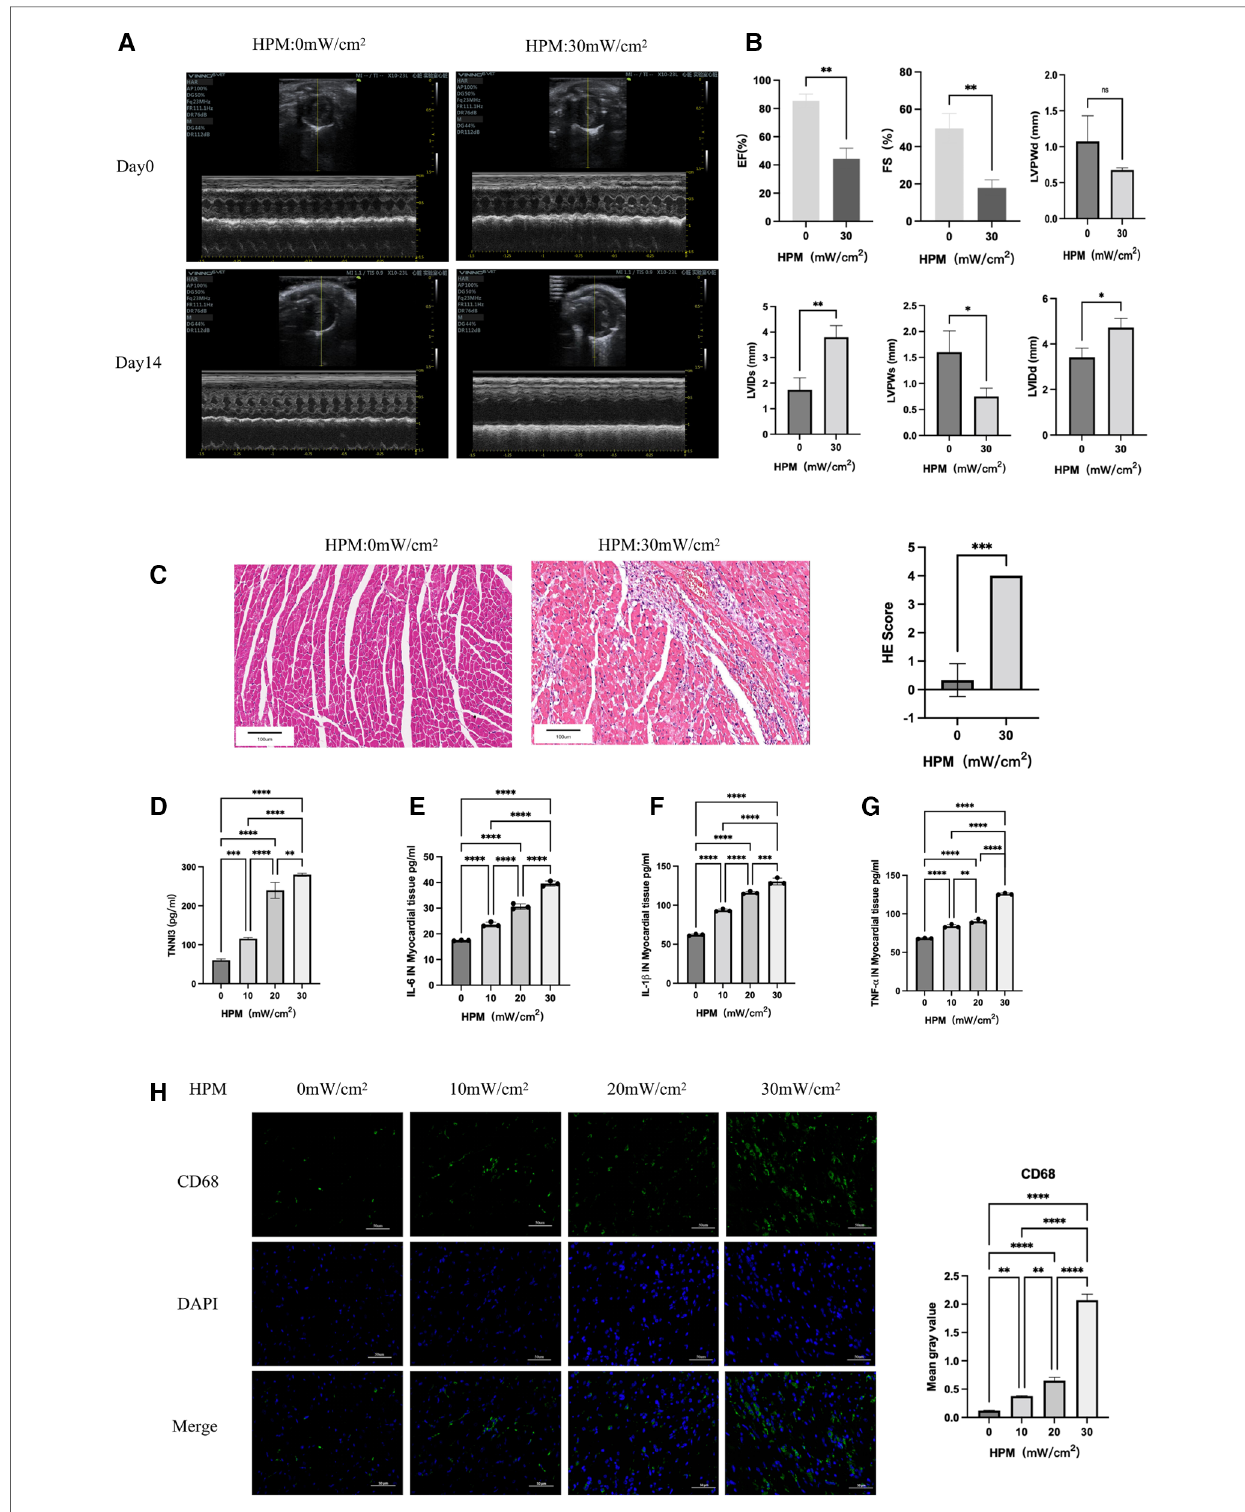
FIGURE 1 HPM causes myocardial damage in mice ( n =6). ( A ) Echocardiography in HPM 0 mW/cm 2 and HPM 30 mW/cm 2 mice pre and after HPM. ( B ) Parameters of HPM 0 mW/cm 2 and HPM 30 mW/cm 2 mice cardiac function, EF, FS, LVPWd, LVids, LVPWs and LVIDd. ns, P >0.05; *, P <0.05; **, P <0.01, Student ’ s t - test. ( C ) HE staining in mouse myocardial tissue. Scale bar: 100 μ m. On the right, the number of in fl ammatory cells per mouse under the microscope is counted. Data presented are mean±SD of microscopic myocardial injury scores. ***, P <0.001, Student ’ s t -test. ( D ) TNN3 concentration in mouse serum.**, P<0.01, one-way ANOVA, post hoc comparisons, Tukey ’ s test. ( E – G ) Elisa test the levels of IL-6, IL-1 β and TNF- α in myocardial tissue of mice. **, P<0.01,***, P <0.001, one-way ANOVA. ( H ) Immuno fl uorescence technique staining of CD68, DAPI in myocardial section were conducted. On the right are the corresponding fl uorescence statistics. Scale bar: 50 μ